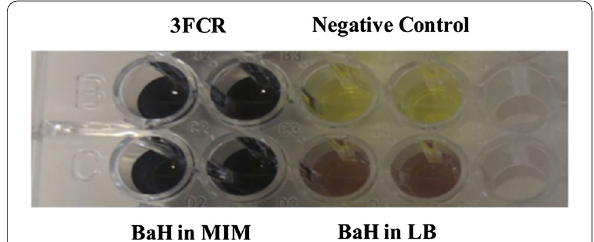
Fig. 2 Effect of medium in induction of ω-TA. Cells grown in LB and MIM media with equal OD were applied in the reaction, including OXD and pyruvate as amine donor and amine acceptor, respectively, in HEPES buffer. 3FCR was used as a positive control. Reaction without cell was applied as a negative